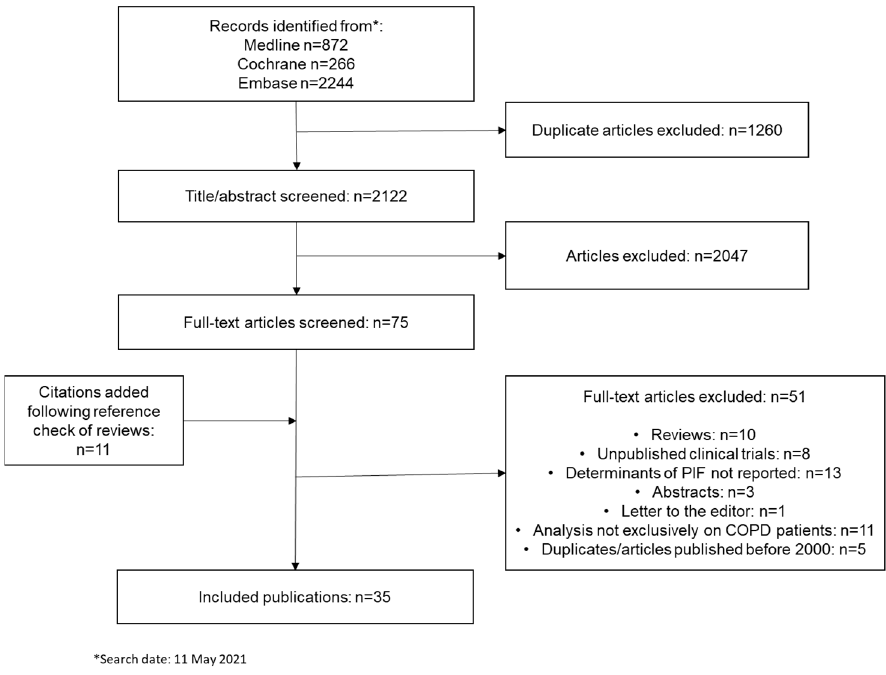
Figure 1. PRISMA flowchart illustrating the selection process of articles.